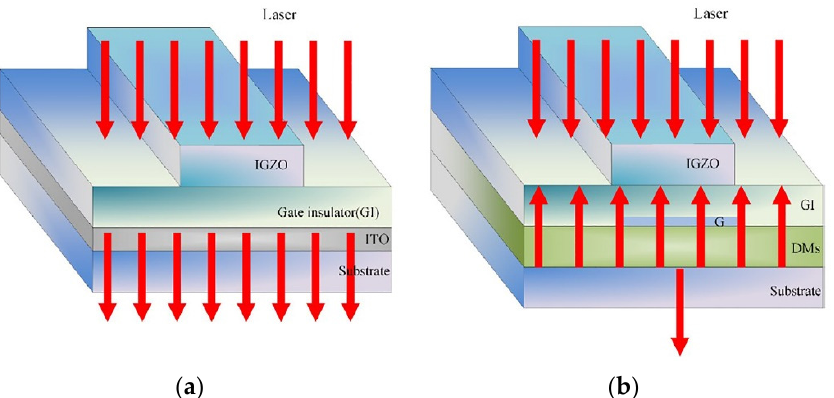
Figure 10. Protective effect of DMs on flexible substrate: ( a ) without DMs; ( b ) with DMs [75].